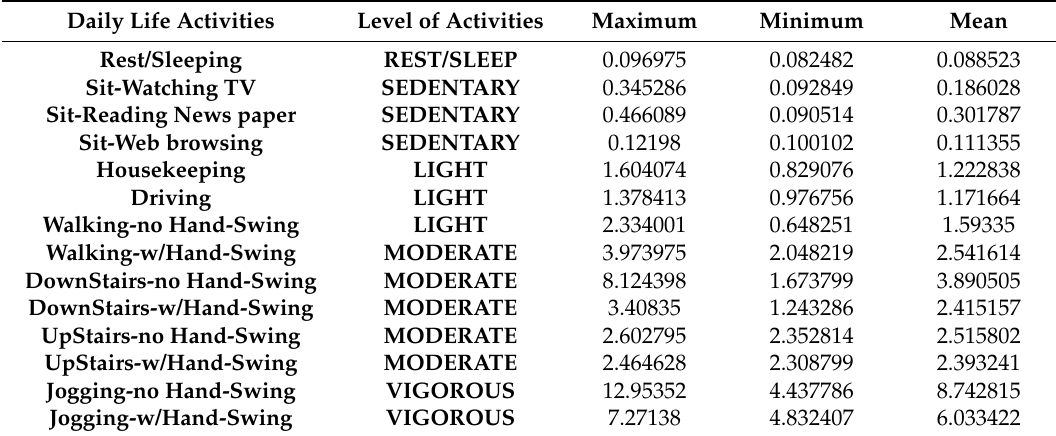
Table 1. Classification of different PAs based upon AI.